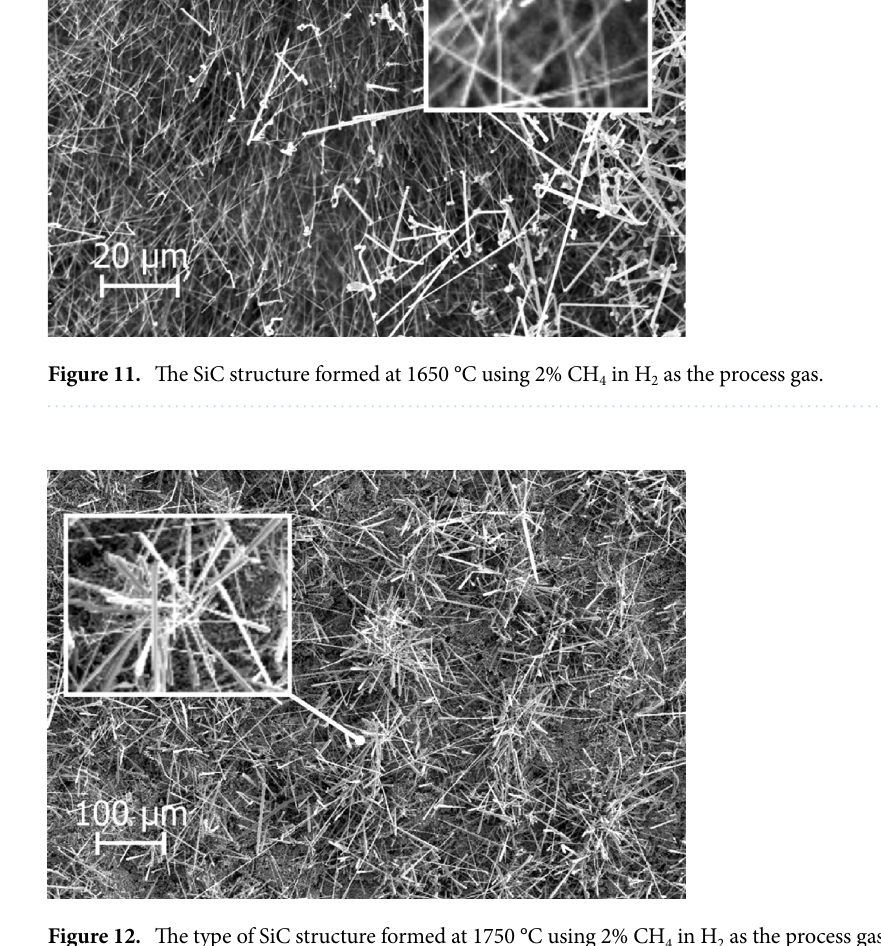
Figure 12. The type of SiC structure formed at 1750 °C using 2% CH 4 in H 2 as the process